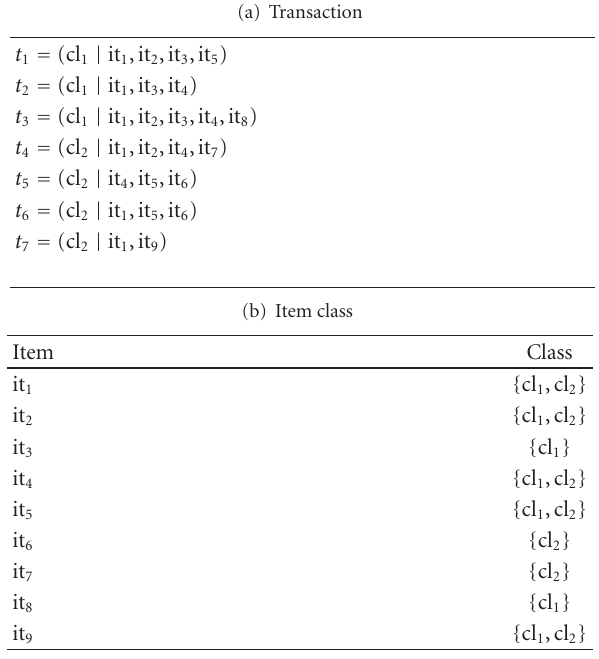
Table 7: An example of transactions and item classes (3).